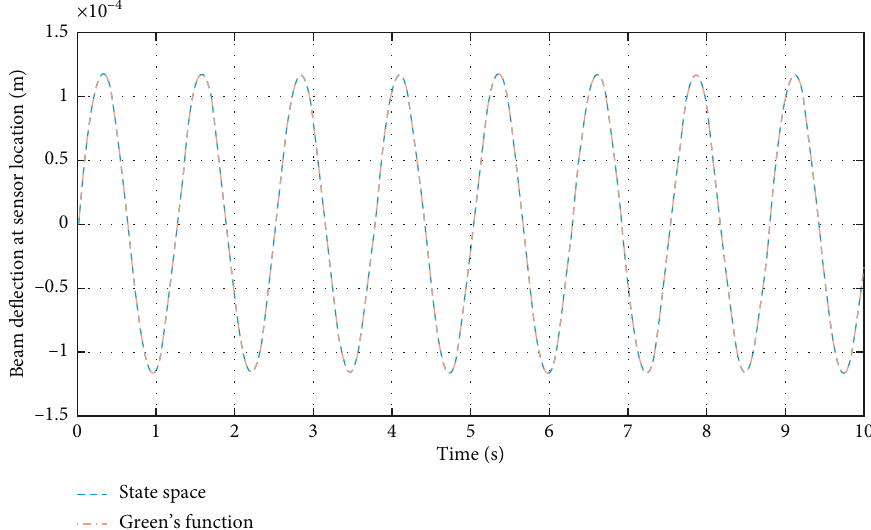
Figure 17: Beam deflection at sensor location ( w ( x